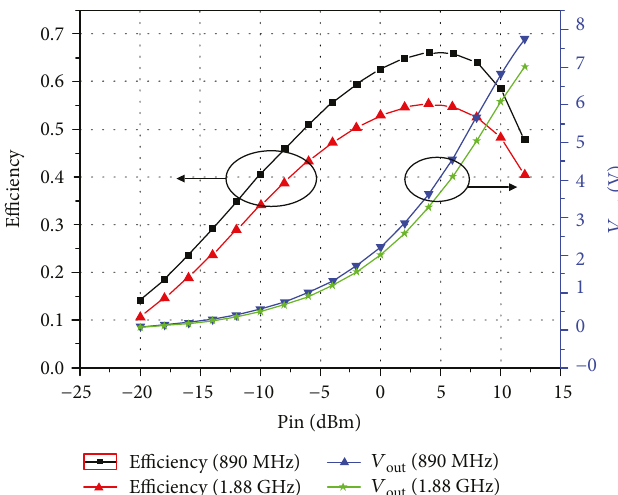
Figure 12: Measured RF-dc e ffi ciency versus input power. Table 1: Indoor measured results of the rectenna at 1